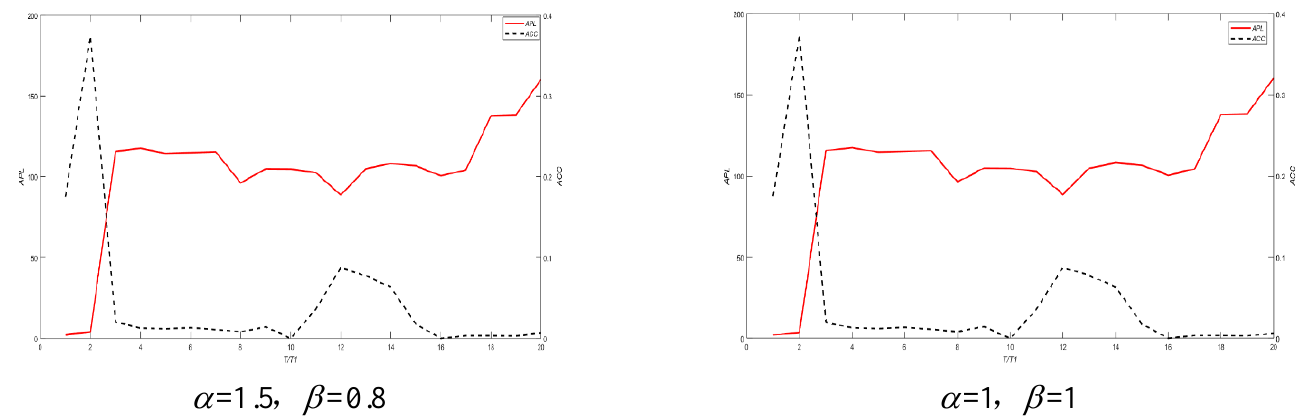
Figure 12. Effect of changes in control coefficients α , β of knowledge distance on APL and ACC